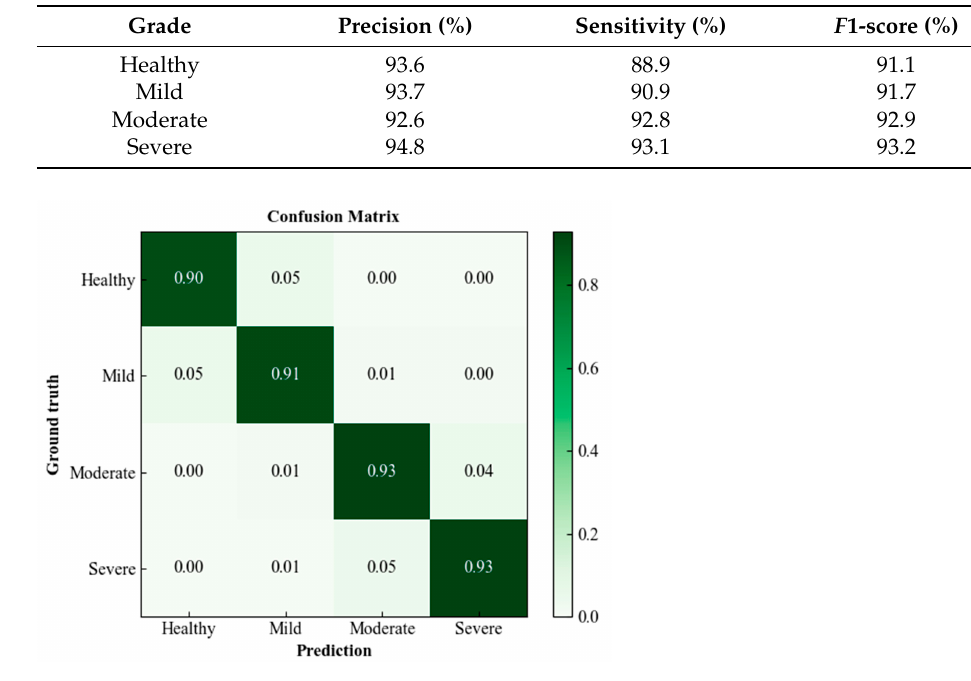
Figure 11. Confusion matrix for four wheat FHB resistance grades. (For each grade, the total number of the ground truth is not equal to that of the prediction since the model fails to detect every spike of the ground truth.)